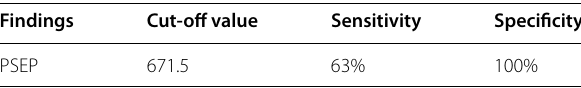
Table 8 Cut‑off value Findings